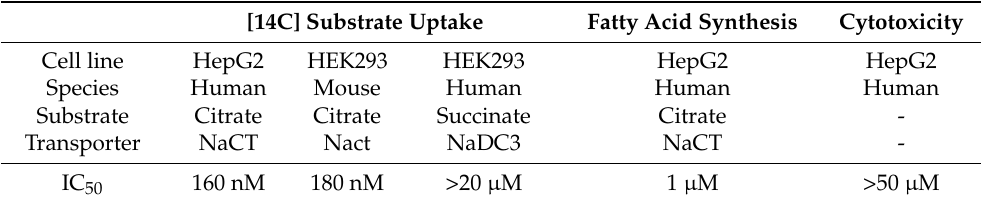
Table 1. In vitro data for the effect of the inhibitor ETG-5773 on cell lines expressing human and mouse